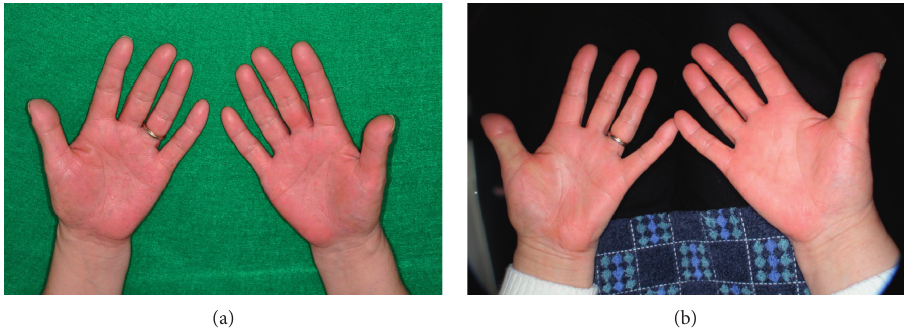
Figure 1: Appearances of the palm at (a) first visit and (b) 1 year after periodontal treatment. (a) Scaly erythemas with tiny pustules were scattered on the palm. (b) Marked improvement was observed after periodontal treatment.